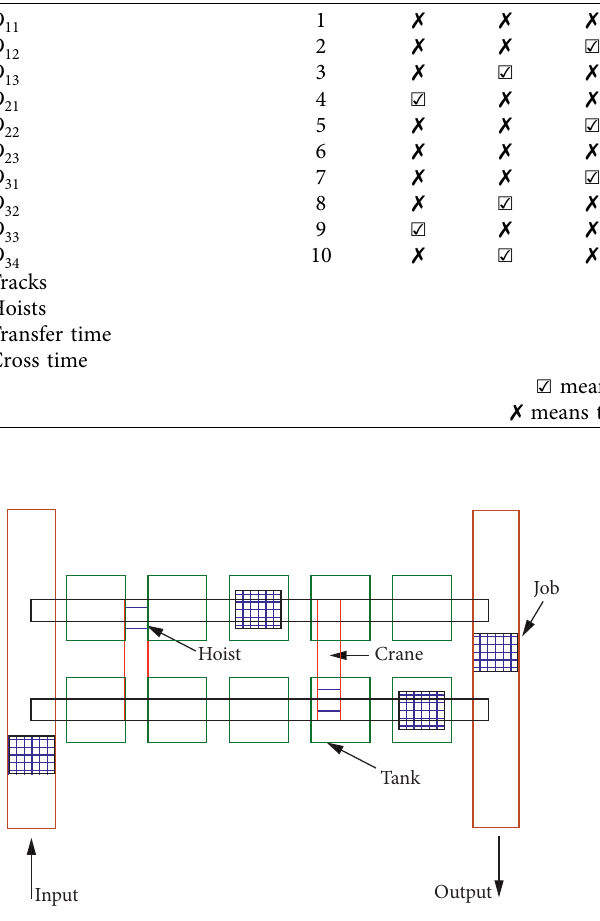
Figure 3: Multihoist layout